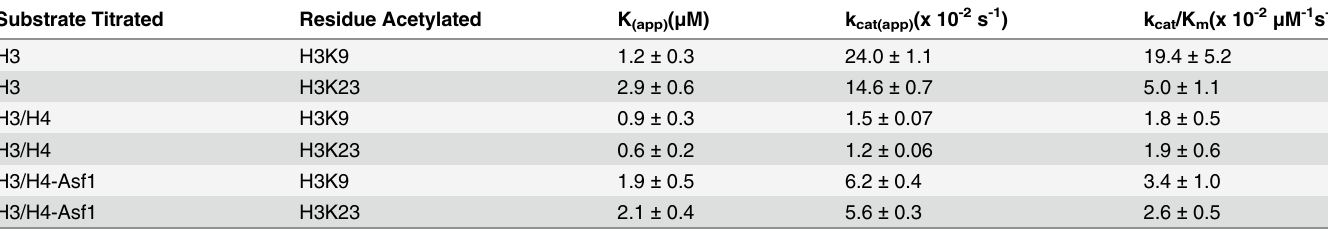
Table 1. Steady-state parameters from kinetic assays of histone titration (mean ± standard error). Substrate